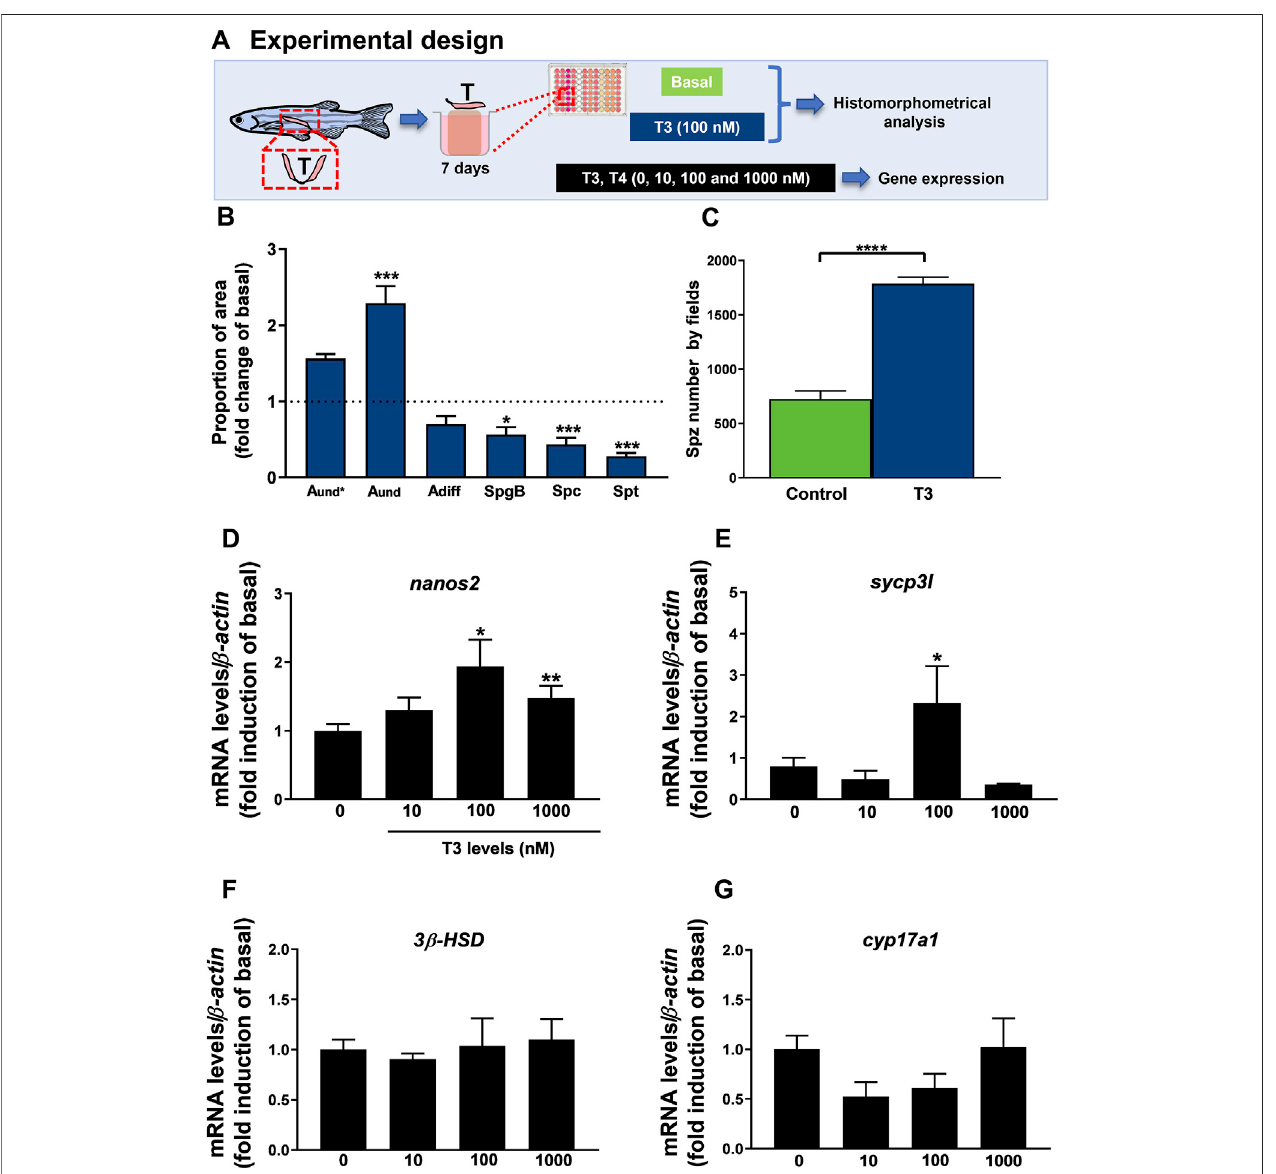
FIGURE 6 | (A) Experimental design of histomorphometrical analysis of zebra fi sh testicular explants incubated for 7 days (long-term exposure) with T3 (100 nM) compared to the control (basal) and gene expression of relative mRNA levels of several selected genes in zebra fi sh testis incubated to different concentrations of T3 (0, 10, 100 e 1,000 nM) for 7 days. (B) Histomorphometrical analysis of testicular explants containing types A undifferentiated spermatogonia (A und*, A und ), type A differentiated spermatogonia (A diff ), type B spermatogonia (SpgB), spermatocytes (Spc), and spermatids (Spt). Bars (mean ± SEM; n = 8) are expressed as fold- change relative to the untreated group (control) (dotted black line set at 1). (C) Spermatozoa number per fi eld generated by using IMAGEJ Software from zebra fi sh explants incubated for 7 days with basal (L-15) and T3 (100 nM). Bars (mean ± SEM; n = 8). Student paired t -test, * p < 0.05 and *** p < 0.001 denote signi fi cant differences between control and treated fi sh. The selected genes nanos2 (D) , sycp3l (synaptonemal complex protein 3) (E) , 3 β -HSD (3-beta ( β )-hydroxysteroid dehydrogenase) (F) ,and cyp17a1 (17 α -hydroxylase/17,20lyase/17,20desmolase) (G) wereevaluated.Ctvalueswerenormalizedwith β -actin andexpressedasrelative valuesofbasallevelsofexpression.Barsrepresentthemean±SEMfoldchange( n =8),relativetothecontrol(basal),whichissetat1.Paired t-test ,* p < 0.05, **p < 0.01 .